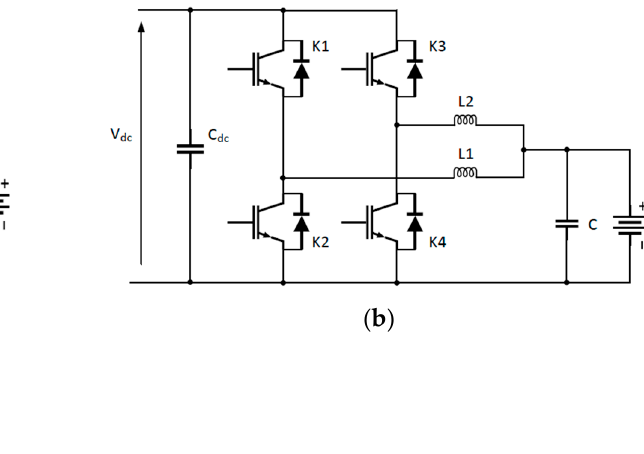
Figure 8. The electrical schematics of the commonly used bidirectional ac-dc power conversion stage in EV chargers: ( a ) Bidirectional half-bridge single-phase ac-dc power converter; ( b ) Bidirectional full-bridge single-phase ac-dc power converter; ( c ) Bidirectional three-phase ac-dc power converter; ( d ) Bidirectional three-level diode-clamped ac-dc power converter.